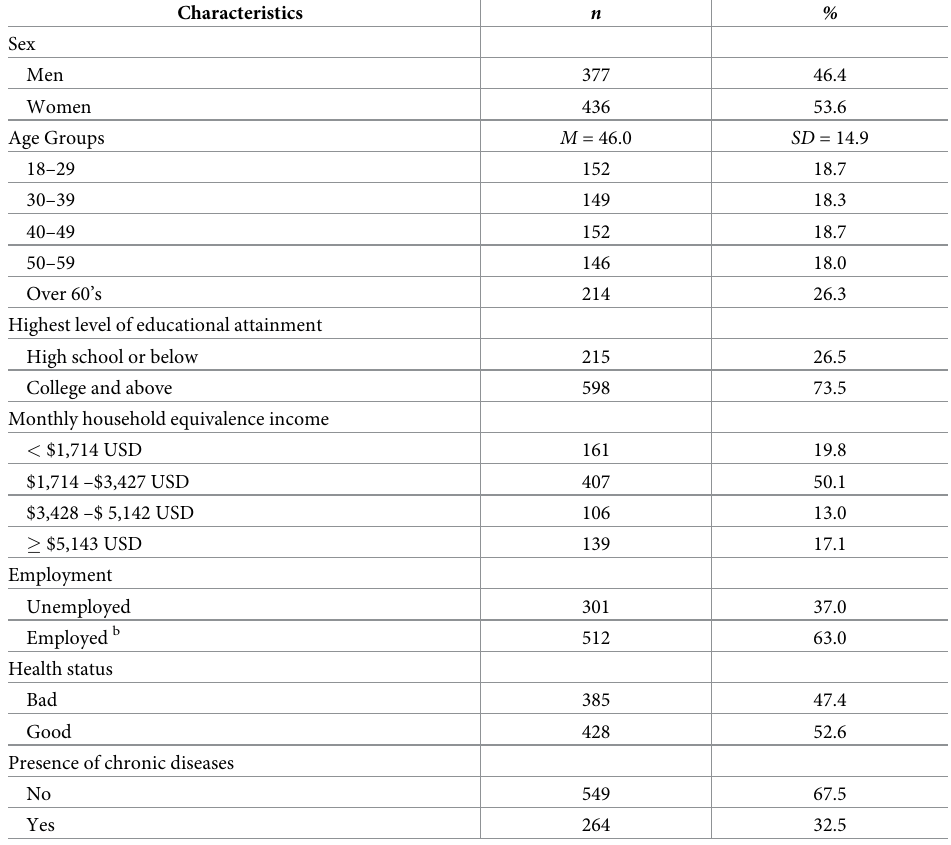
Table 1. Descriptive statistics and psychological distress of the participants ( n = 813).